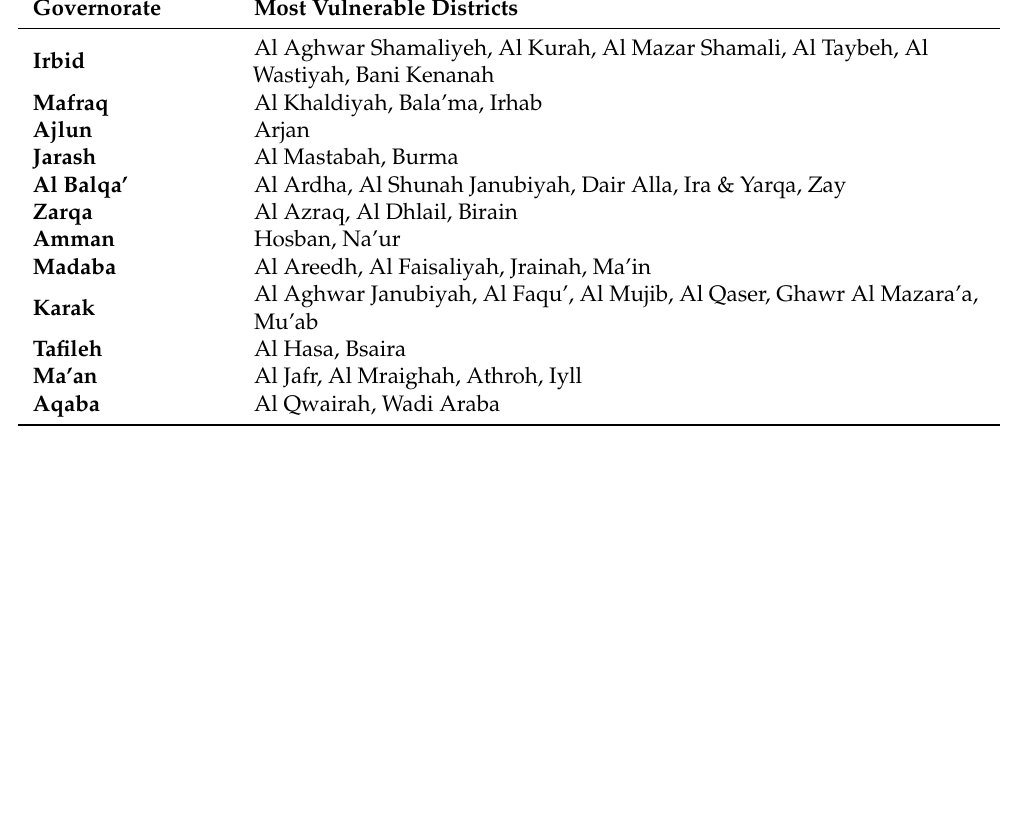
Figure 13. Final Sanitation Hotspots Map.